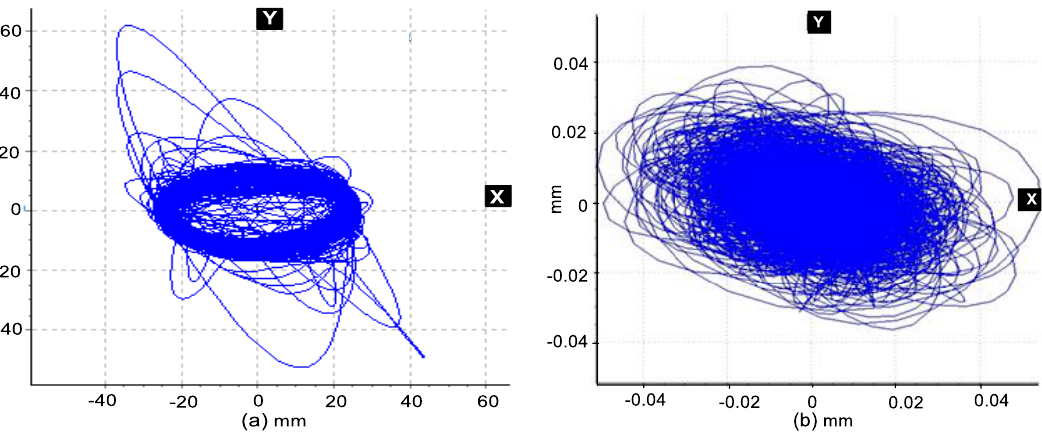
Figure 18. Experimental orbit response of imbalanced rotor-casing rub ( a ) without water and ( b ) with water . with